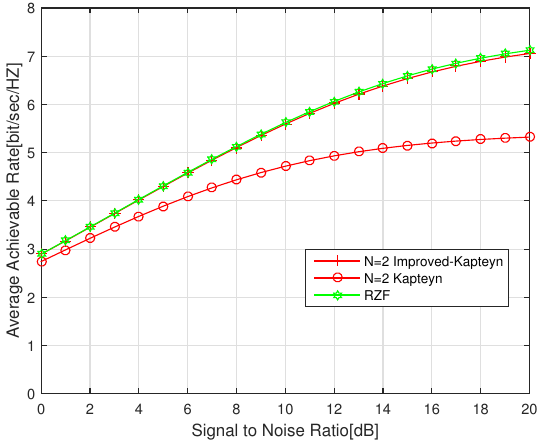
Figure 4. Average achievable rate vs. SINR ( M = 256, K = 32, τ =